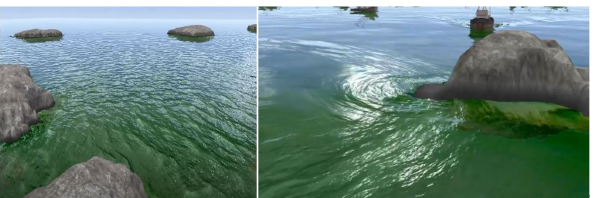
Figure 8. Simulation Effect Image produced using WWS [8]